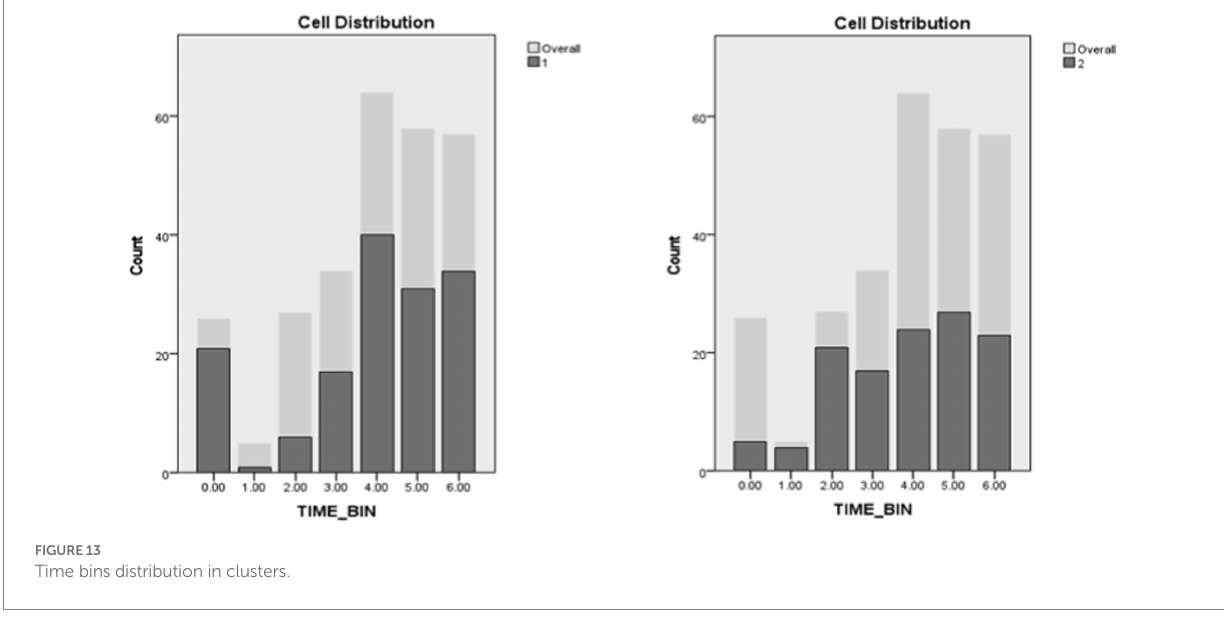
FIGURE 13 Time bins distribution in clusters.